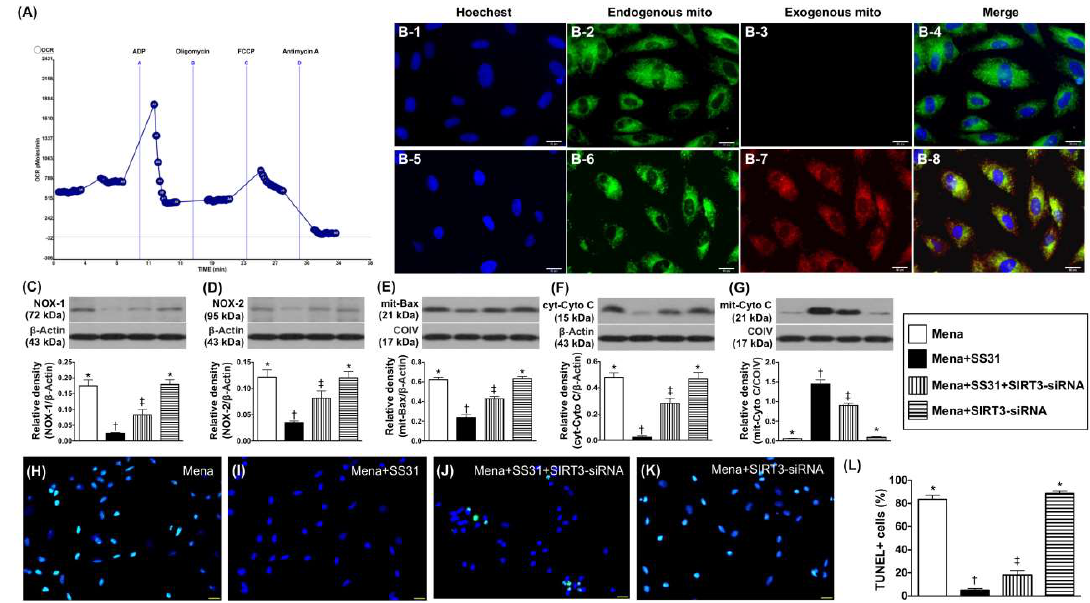
Figure 3. Refreshment of mitochondria in H9C2 cells and SS31 cyto-protective effect abolished by SIRT3 suppression. ( A ) Activity (OCR) of isolated mitochondria (determined by the Mito stress test kit and the XF e 24 Analyzer) ( n = 4). ( B ) Immunofluorescent (IF) (400 × ) staining showing nuclear DAPI stain ( B-1 , B-5 ), endogenous mitochondria ( B-2 , B-6 ), exogenous mitochondria (red color) being transferred into H9C2 cells ( B-7 ), and ( B-3 ) indicating that no exogenous mitochondria are transfused into H9C2 cells. ( B-4 ) indicating merged of ( B-1 – B-3 ), and ( B-8 ) indicating merged pictures of ( B-5 – B-7 ) with a yellow-green color indicating the fusion of exogenous and endogenous mitochondria in H9C2 cells. ( C ) Protein expression of NOX-1, * vs. other groups with different symbols (†, ‡), p < 0.0001. ( D ) Protein expression of NOX-2 * vs. other groups with different symbols (†, ‡), p < 0.0001. ( E ) Protein expression of mitochondrial Bax * vs. other groups with different symbols (†, ‡), p < 0.0001. ( F ) Protein expression cytosolic cytochrome C (cyt-Cyto C) * vs. other groups with different symbols (†, ‡), p < 0.0001. ( G ) Protein expression of mitochondrial cytochrome C (mit-Cyto C) * vs. other groups with different symbols (†, ‡), p < 0.0001. ( H – K ) Illustrating the microscopic finding (400 × ) of TUNEL assay for the identification of apoptotic nuclei (green color) in H9C2 cells. ( L ) Analytical results of the number of apoptotic nuclei * vs. other groups with different symbols (†, ‡), p < 0.0001. The blue color indicated nuclei stained by DAPI. All statistical analyses were performed by one-way ANOVA, which was followed by a Bonferroni multiple comparison post hoc test ( n = 6 for each group). Symbols (*, †, ‡) indicate significance at the 0.05 level. Mena = menadione.